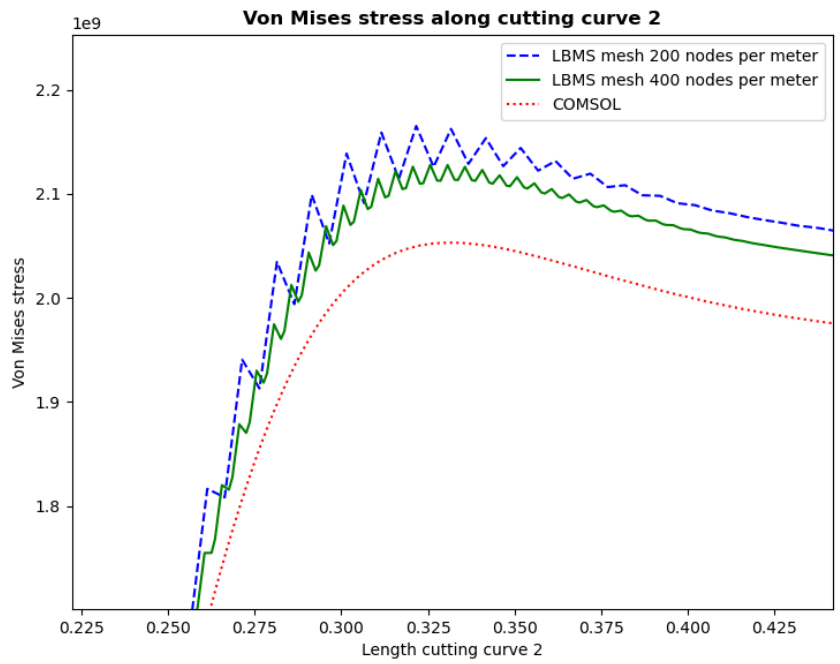
Figure A2. Detailed view of Von Mises stress along cutting curve C 2 for case E = 200 GPa, ν =